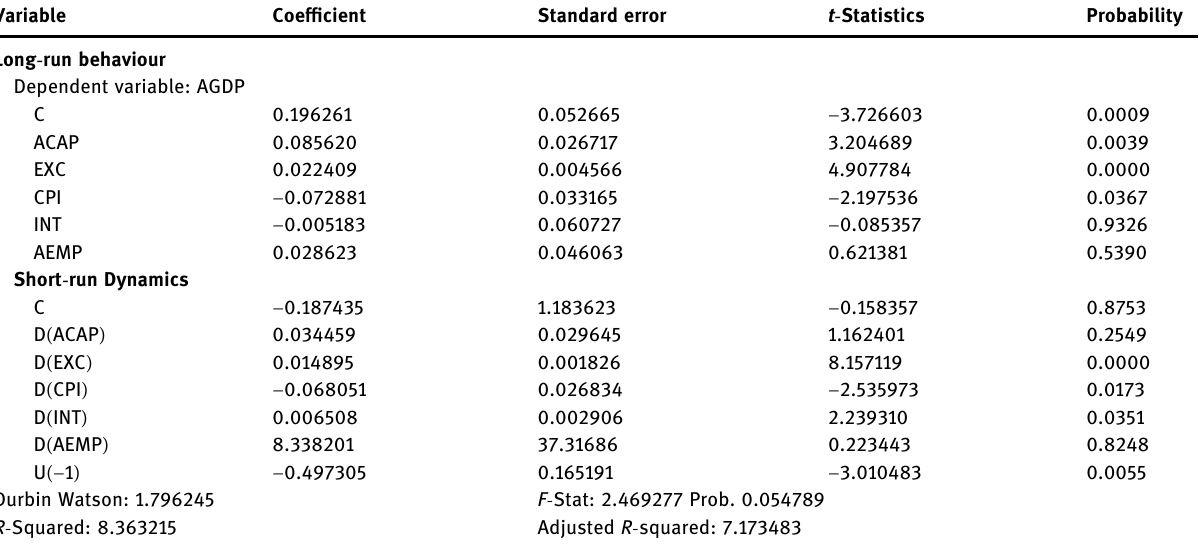
Table 2: Long - run and short - run dynamics for model 1 Variable